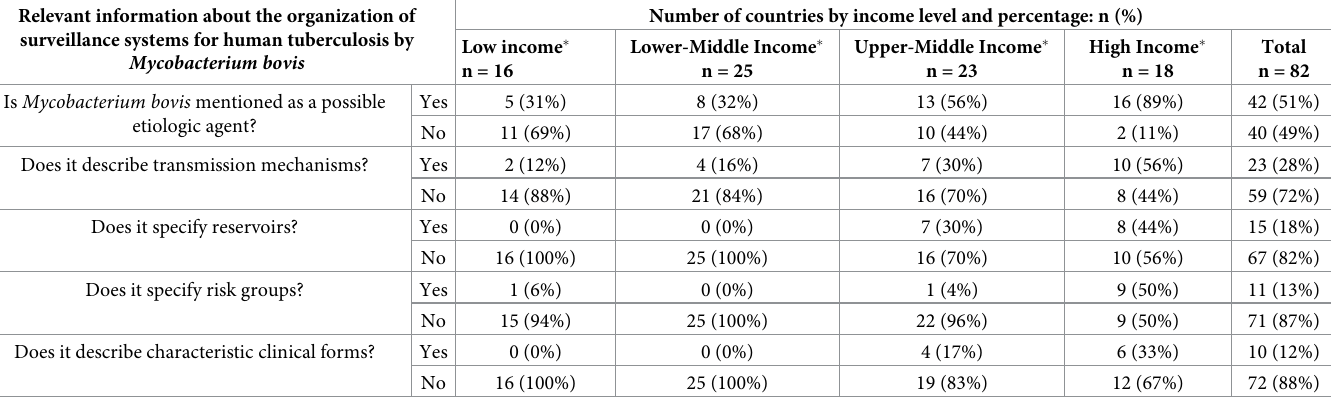
Table 2. Key aspects of surveillance of human tuberculosis caused by Mycobacterium bovis in 82 countries assessed, by income level. Relevant information about the organization of surveillance systems for human tuberculosis